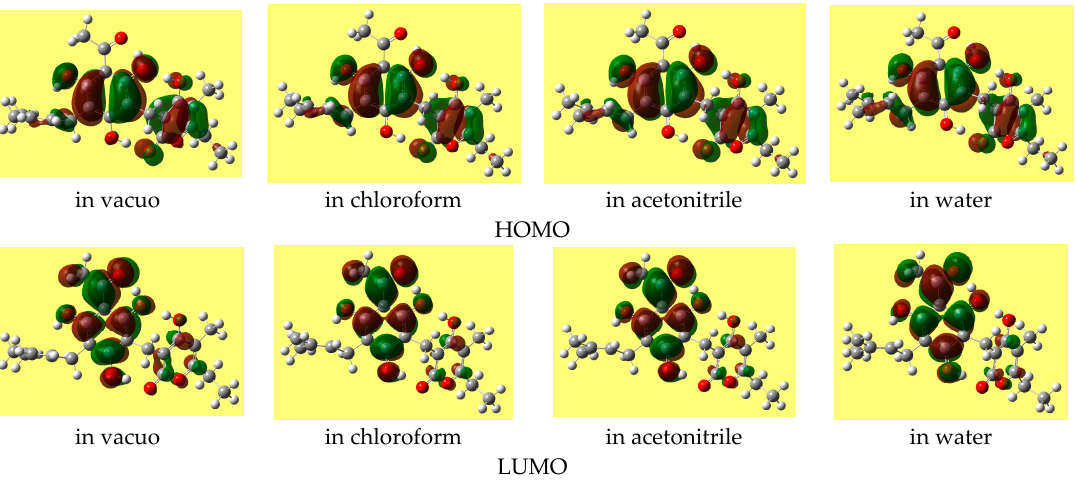
Figure 5. Frontier orbitals of the lowest energy conformer (1-d-r- ξ - αδ ) in different media. DFT/B3LYP/6-31+G(d,p) results from calculations with fully relaxed geometry in all the media.